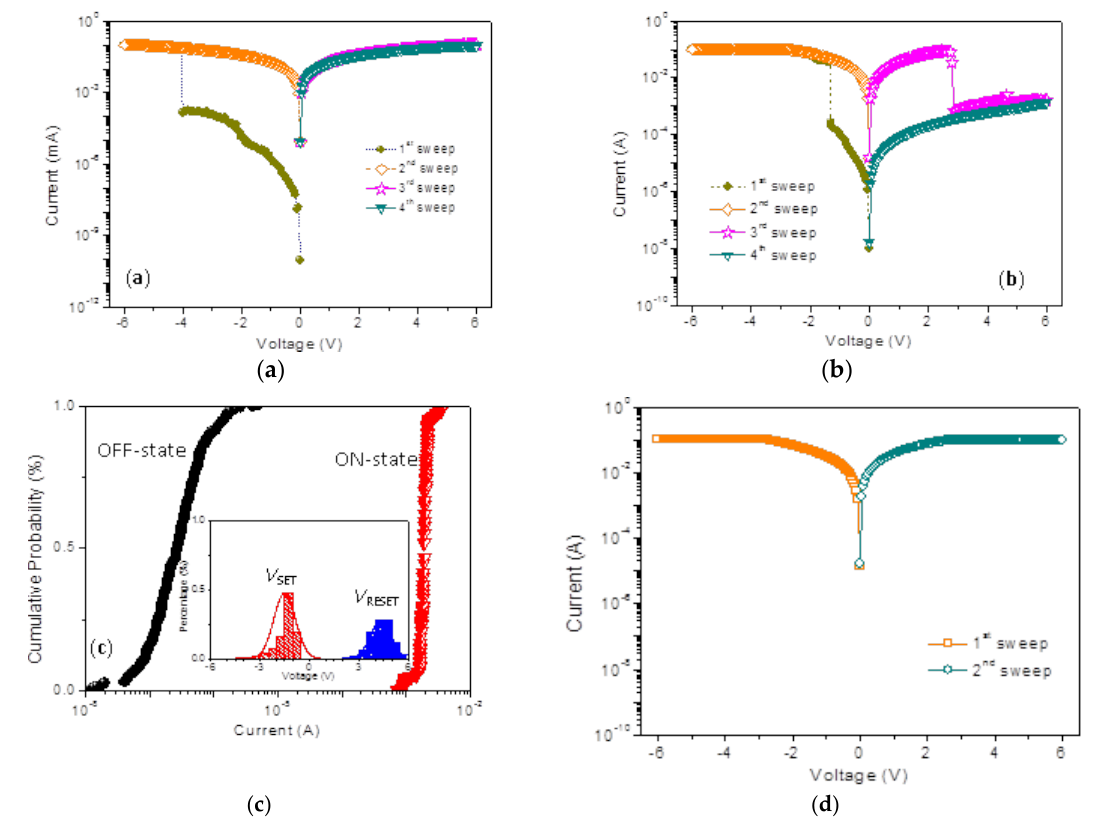
Figure 6. I - V Characteristics of Ni/PMMA:GO/ITO in terms of different GO weight ratios ( a ) 1 wt%, ( b ) 3 wt%, and ( d ) 5 wt%; ( c ) Cumulative probability of I OFF and I ON for 300 operation cycles at reading voltage of − 0.1 V together with the data distribution of V SET and V RESET .